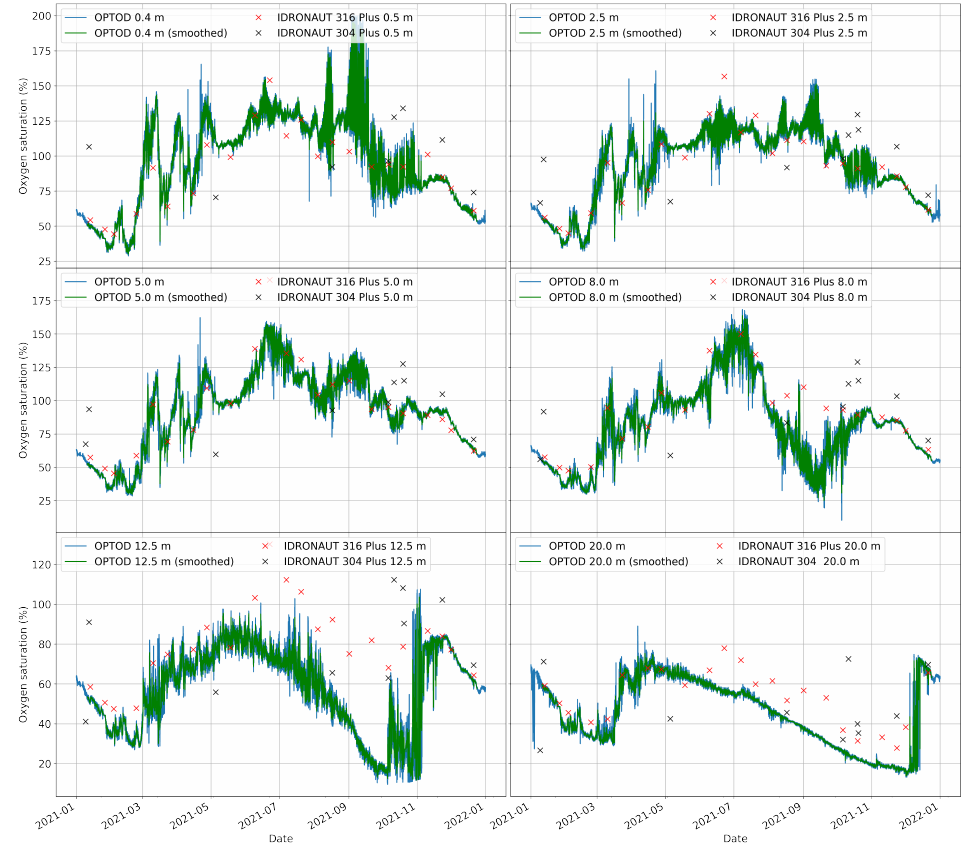
Figure 17. General overview of the time-series comparison between AHFM and IDRONAUT